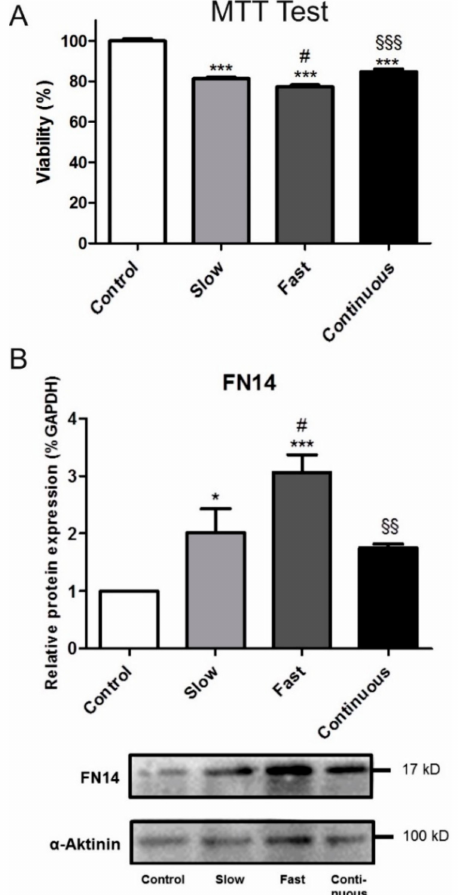
Figure 6. The viability of tubular epithelial cells (NRK-52E; ATCC) assessed by 3-[4,5-dimethylthiazol- 2-yl]-2,5-diphenyltetrazolium bromide (MTT) test ( A ). Cells treated for 12 h with Tac according to the pharmakokinetic profile of fast metabolizers (Fast) showed the most reduced viability (*** p < 0.001 vs. Control, # p < 0.05 vs. Tac slow, §§§ p < 0.001 vs. Tac fast. Western blot analysis of Fn14